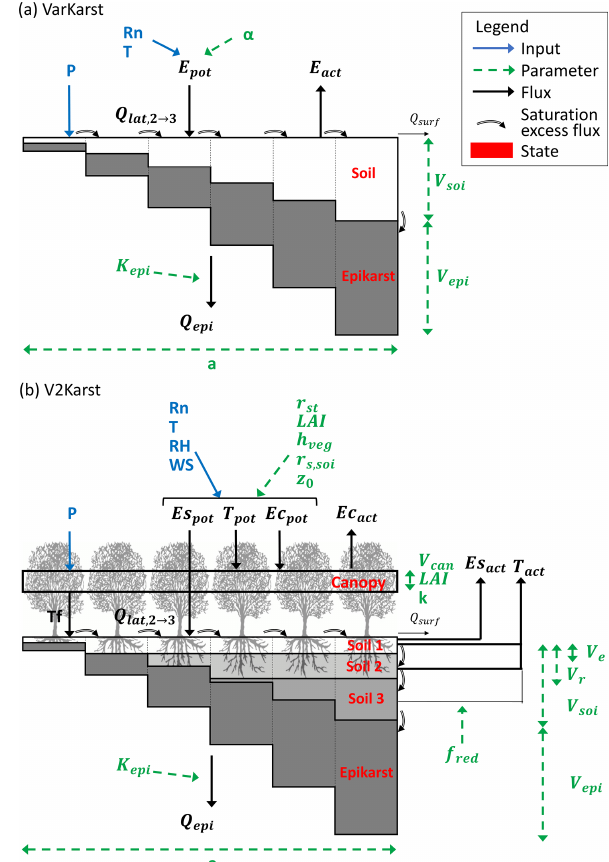
Figure 1. Schematic representation of (a) the VarKarst model (Hart- mann et al., 2015) and (b) the new version of the model V2Karst us- ing six vertical compartments. Model parameters are in green (see their definition in Table 1), inputs are in blue ( P –